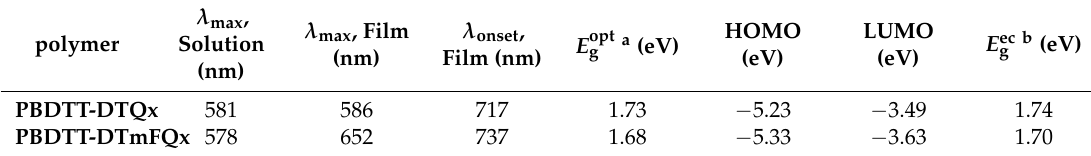
Figure 3. Cyclic voltammogram curves for the copolymers. Table 2. Optical and electrochemical properties of the copolymers.